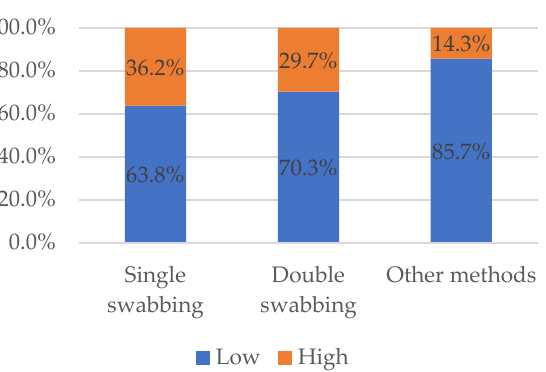
Table 2. Papers categorized in Group 2. Features displayed are authors and publication year, num- ber (n°) of samples collected, sampling methods implemented, important findings, and remarks highlighted. Authors